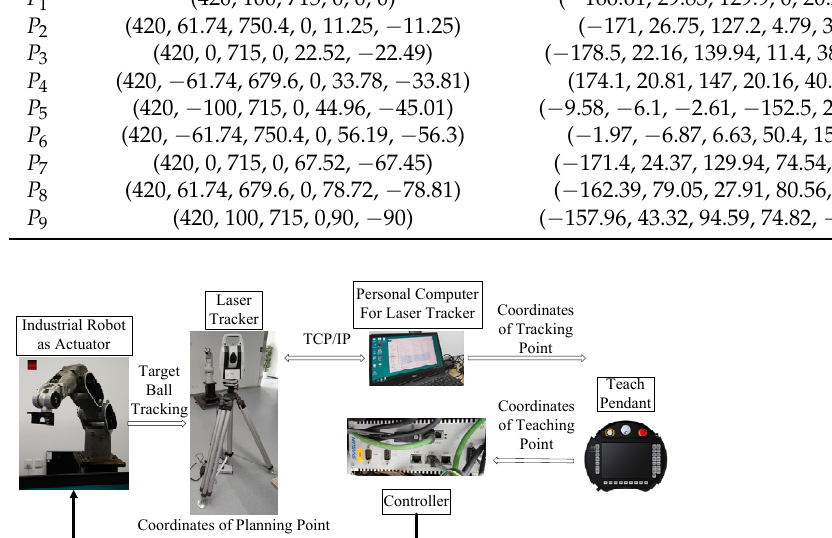
Table 2. Coordinate information of every critical point. Coordinate in Cartesian Space (mm, deg) Coordinate in Joint Space (deg)